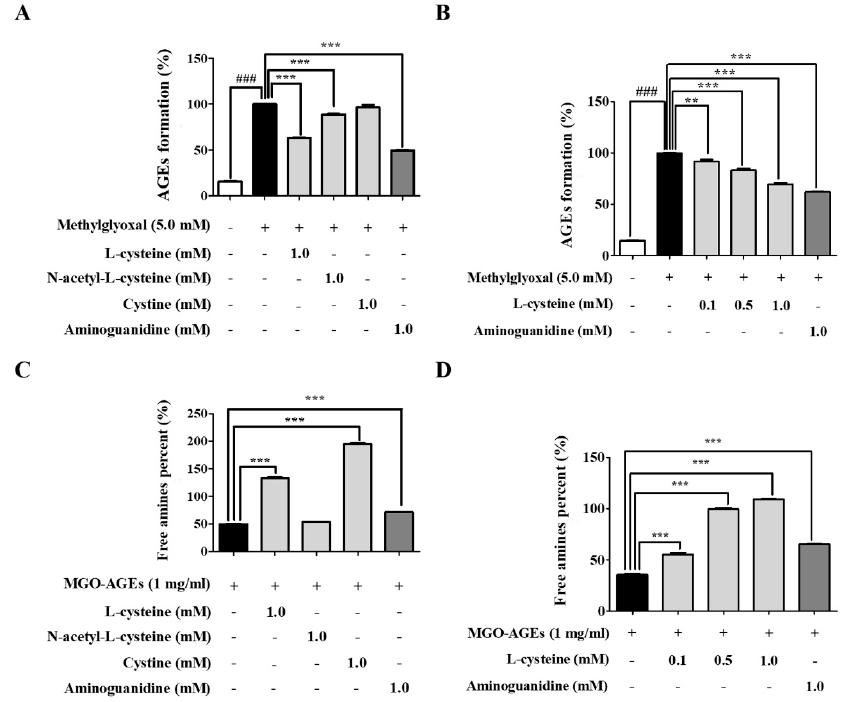
Figure 4. E ff ects of l -cysteine on the advanced glycation end product (AGE) formation and breakdown. ( A , B ) E ff ects of l -cysteine, NAC, and cystine on the in vitro formation of advanced glycation end products (AGEs) were evaluated using an AGE-formation assay; MGO-mediated AGE formation. Five mg / mL bovine serum albumin (BSA) and 0.02% sodium azide were incubated with 5 mM MGO